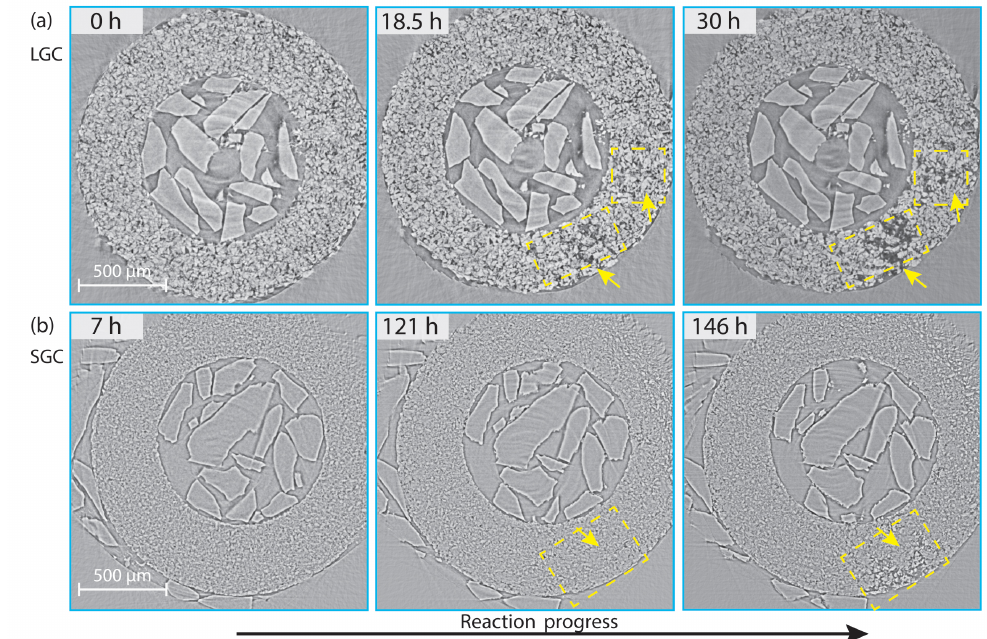
Figure 5. Reconstructed images showing the cross-section view of the sample undergoing olivine carbonation. (a) In the LGC sample, original olivine grains shrink, and secondary pore space appears (yellow arrows), suggesting dissolution of olivine. Most of the large pore spaces concentrate at the interior of the cup wall (highlighted by yellow dashed lines). (b) In the SGC sample, the fractures first developed at the surface of the cup and propagated from the outer rim into the cup wall (highlighted by yellow dashed lines). Larger pore space distributes mainly near the rim.